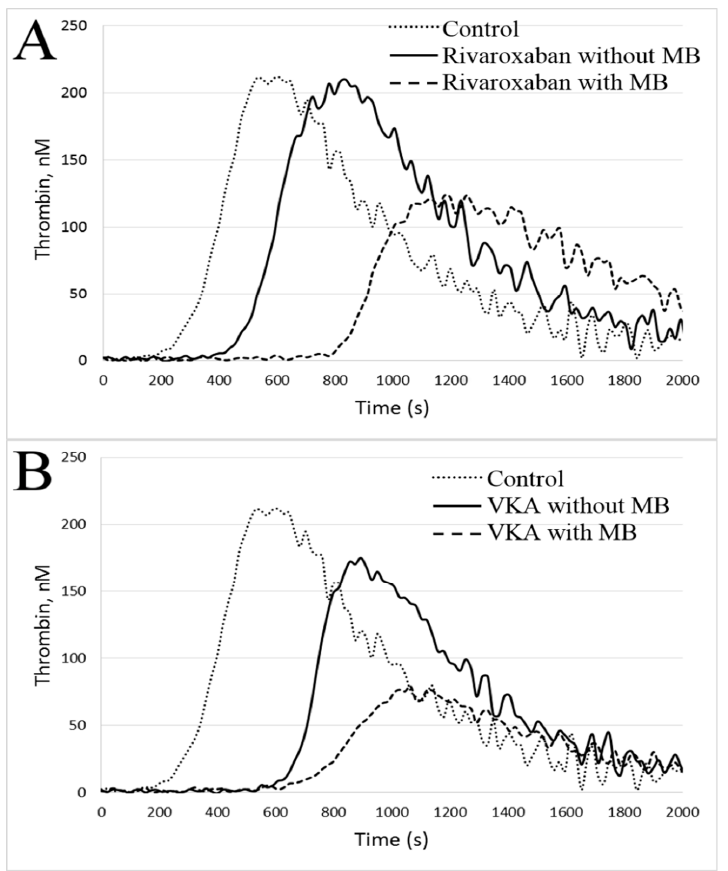
Figure 2. Representative thrombin generation curves in the calibrated automated thrombogram. ( A ). Rivaroxaban vs. control, ( B ). VKA vs. control. Abbreviations: MB: minor bleeding, VKA: vitamin K